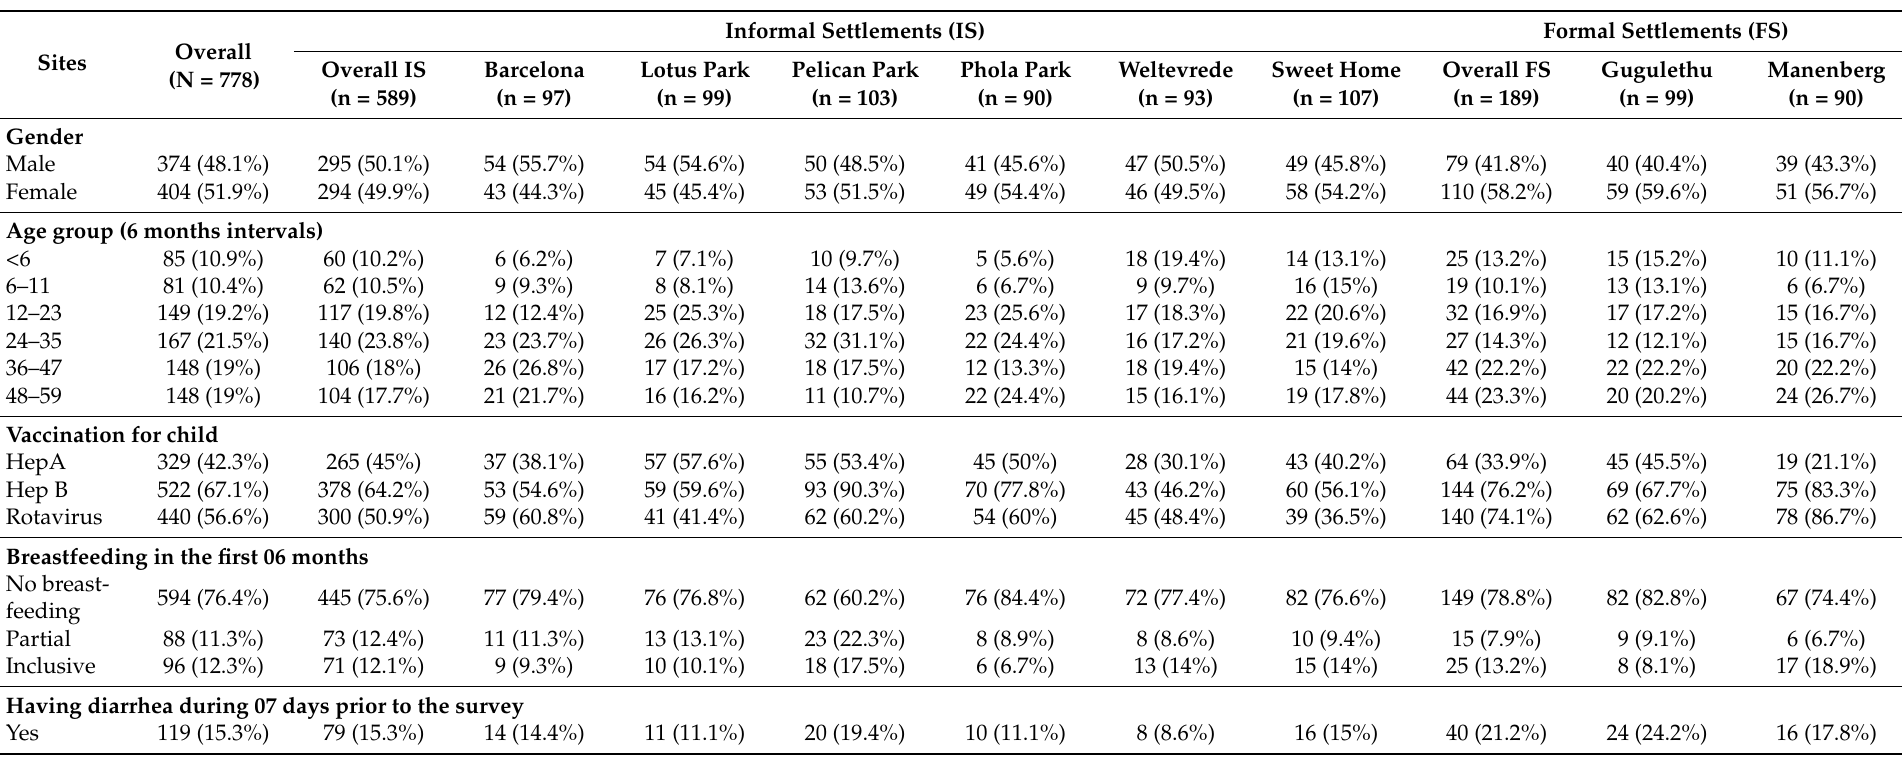
Table 1. Demographic and health-related characteristics of children in participating